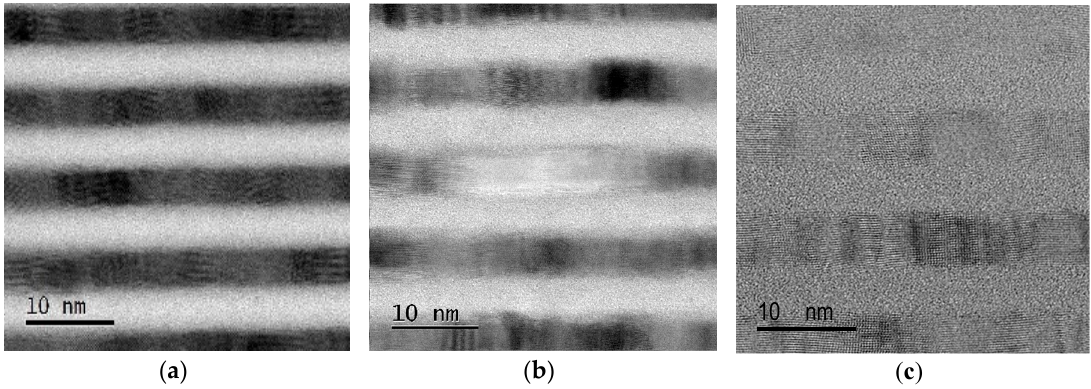
Figure 1. Cross-sectional (bright field) HRTEM images of multilayered films with the ratio of thicknesses of MeN (darker contrast) and SiN x (brighter contrast) elementary layers equal to 5 nm/5 nm: ZrN/SiN x ( a ); CrN/SiN x ( b ); and AlN/SiN x ( c ).